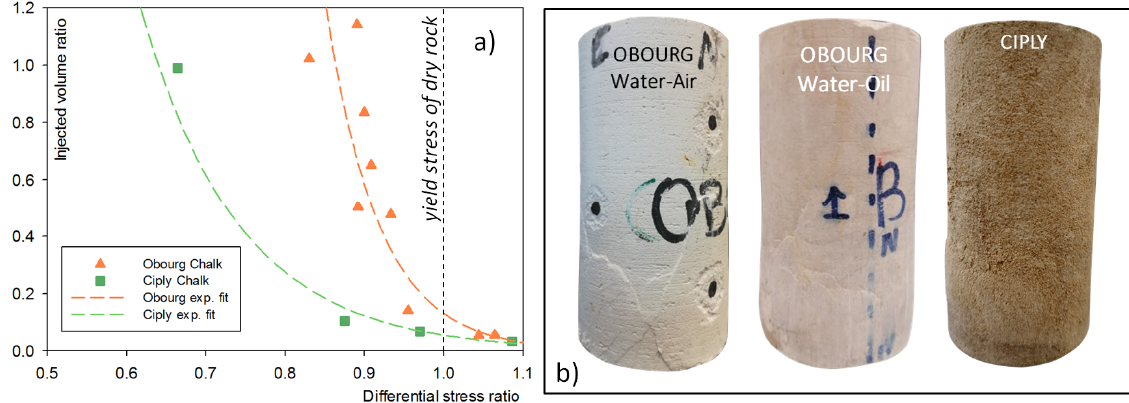
Figure 12. ( a ) Injected water volume normalized to pore volume vs. applied differential stress normalized to the strength of the dry rock at fixed confining pressure (1.5 MPa). ( b ) Samples after failure induced by water injection at constant stress level.